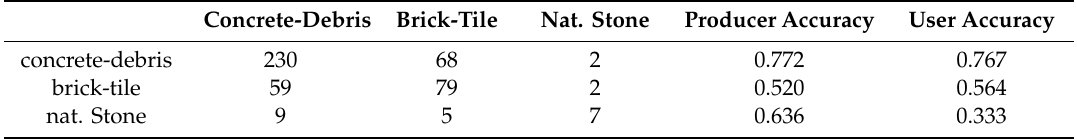
Table 4. Confusion matrices for the recoded PED maps obtained using the 0.25 PMA threshold (461 samples). Table 5. Accuracy parameters of three recoded PED maps obtained using the 0.35 PMA threshold (477 samples).